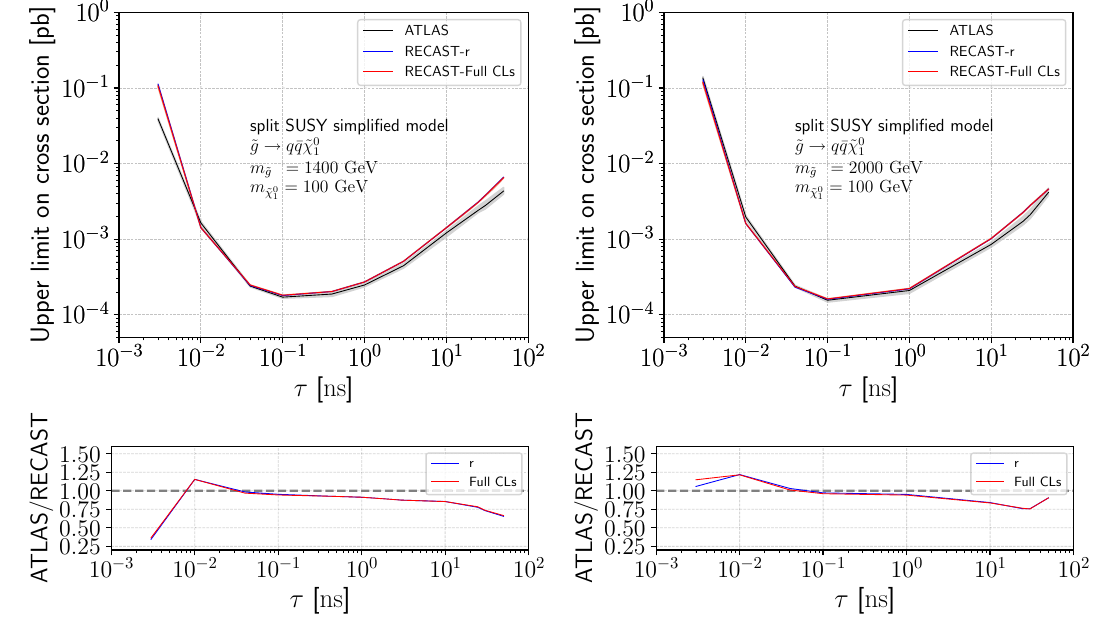
Fig. 2 Validation of the DV+MET search in the scenario with large mass-splitting for two different benchmarks (left m ˜ g = 1 . 4 TeV, right: m ˜ g = 2 TeV). The bottom panel in both cases shows the ratio of the publishedATLASexclusiontotheoneobtainedby CheckMATE .There